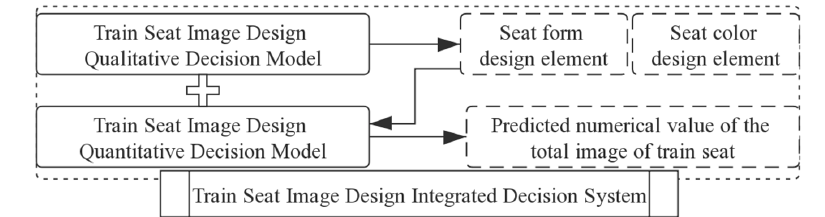
Figure 13. The train seat image design integrated decision system.